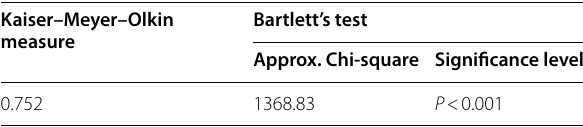
Table 5 KMO and Bartlett